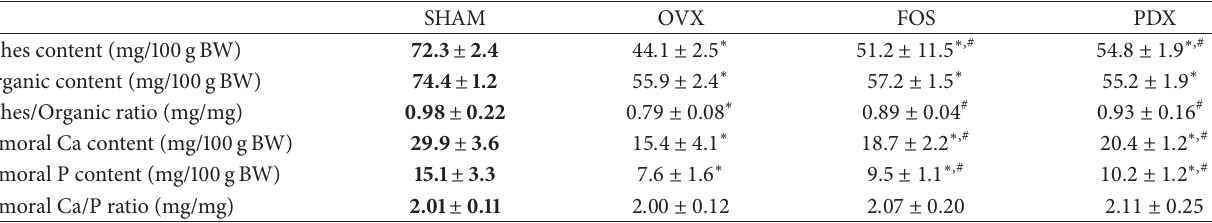
Table 5: Ashes and organic femur content; ashes/organic ratio, Ca and P femur content and femur Ca/P ratio. SHAM OVX FOS PDX Ashes content (mg/100g BW) 72.3 ± 2.4 Organic content (mg/100gBW) 74.4 ± 1.2 Ashes/Organic ratio (mg/mg) Femoral Ca content (mg/100gBW) Femoral Ca/P ratio